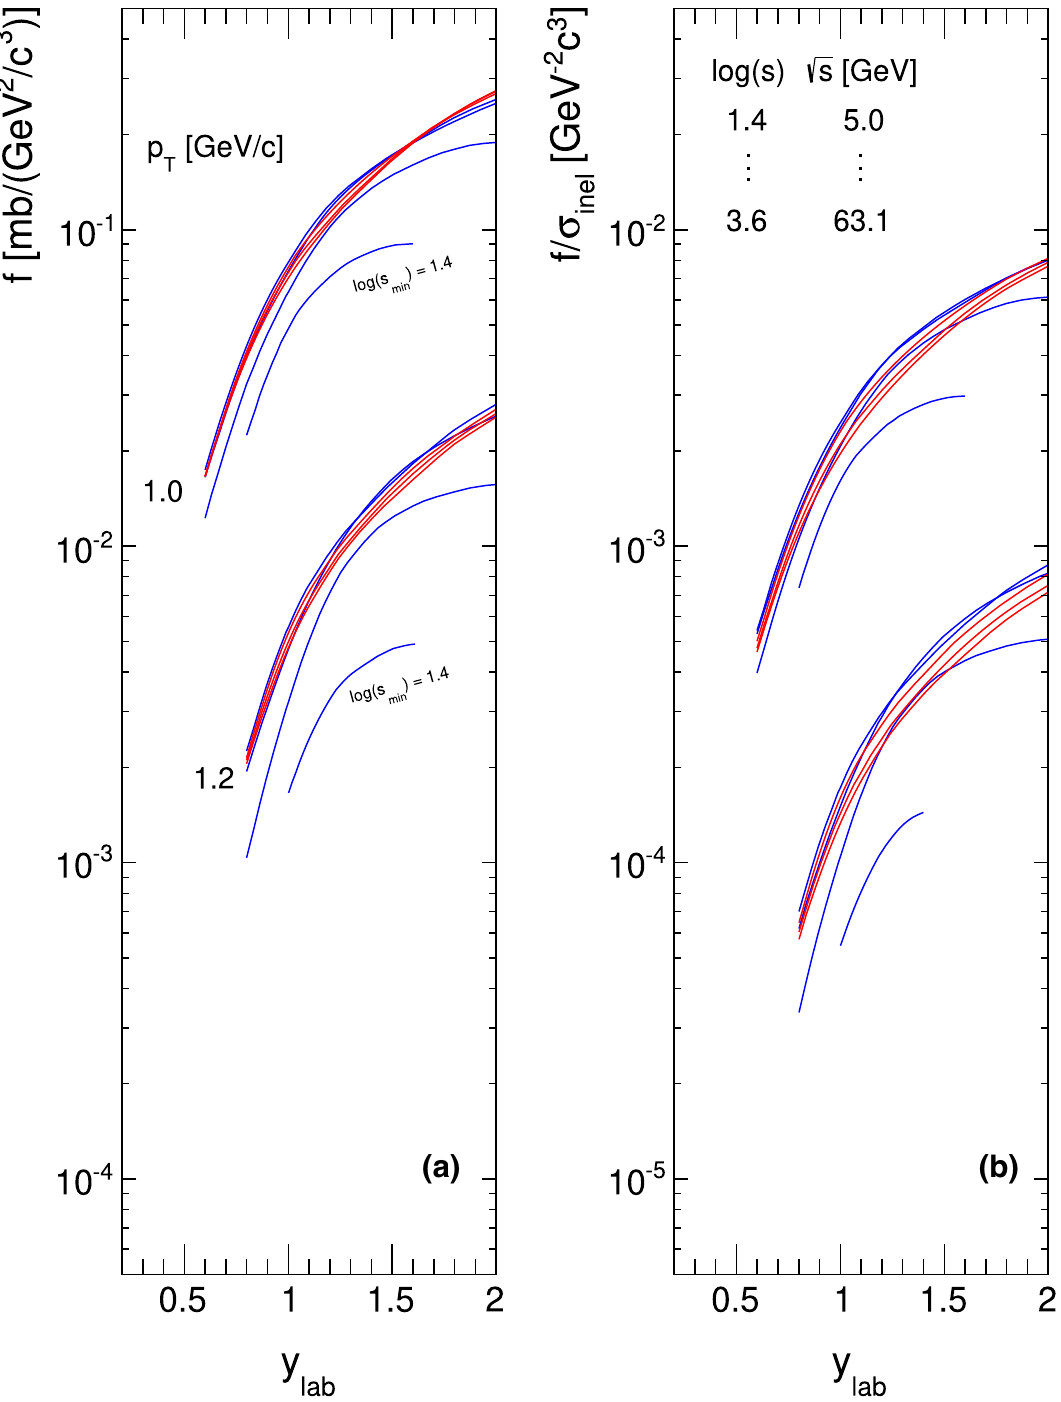
Fig. 109 π − cross sections as a function of y lab for p T = 1.0, 1.2 GeV/c and different log ( s ) values in the range 1 < log s < 3.6; a f ( y lab , p T ) , b f ( y lab , p T )/σ inel . The distributions for different p T values are successively scaled down by factor of 1/3 for better